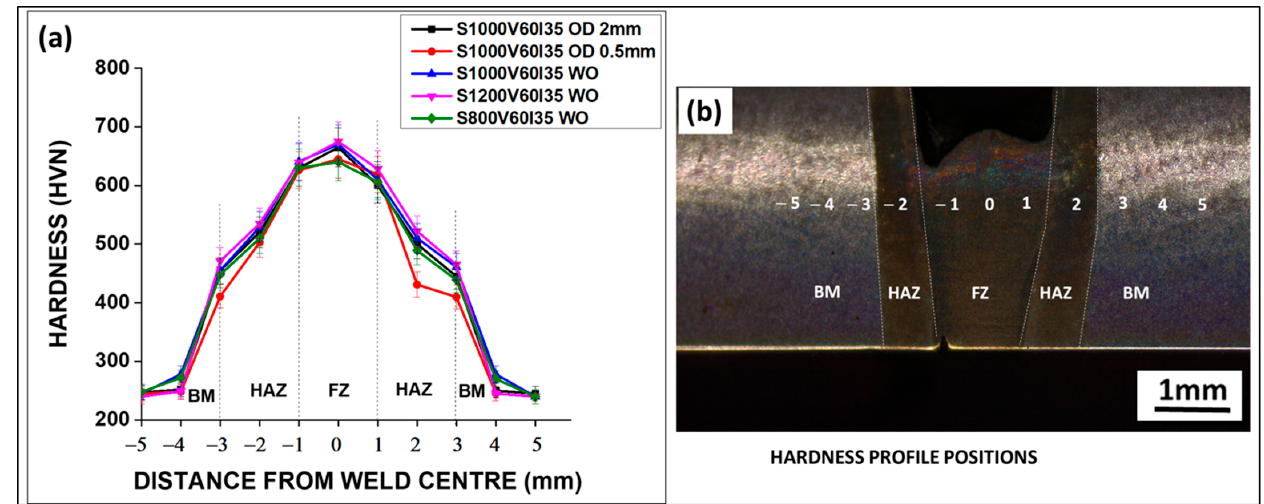
Figure 9. ( a ) Hardness measurement of EN25 steel after welding under different welding conditions, from base metal to heat-affected zone to fusion zone, ( b ) EN25 welded steel sample at different positions from where hardness measurement is taken, starting from point − 5 to 5 in ( a ).